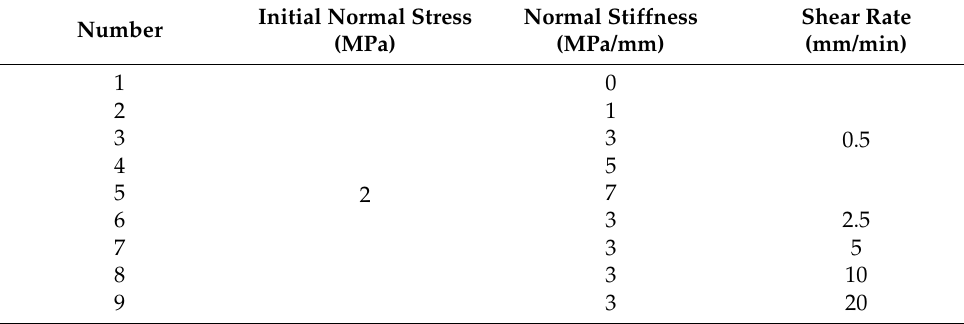
Figure 3. Plan view of the sensor arrangement in the lower shear box; the numbers are sensor ID numbers. Table 2. Loading scheme adopted in the